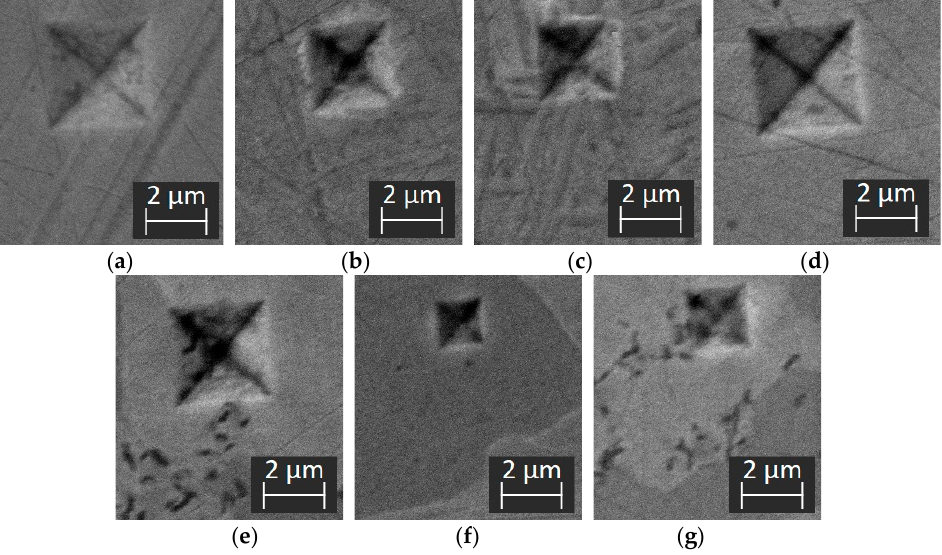
Figure 11. SEM micrographs of the indent marks on: BM ( a ), BM ‐ DAZ ( b ), DAZ ‐ SSP ( c ), SSP ( d ), matrix in MZ ( e ), Ni ‐ B (MZ) ( f ), Pd ‐ Ni ‐ Si (MZ) ( g ).